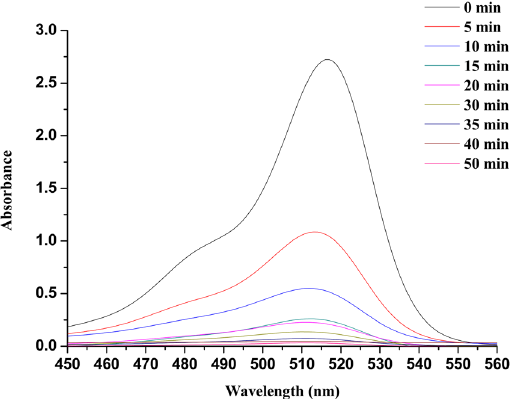
Figure 4. UV-vis absorption spectra of Eosin Y degradation with time catalyzed by Au(Salen)@CC .